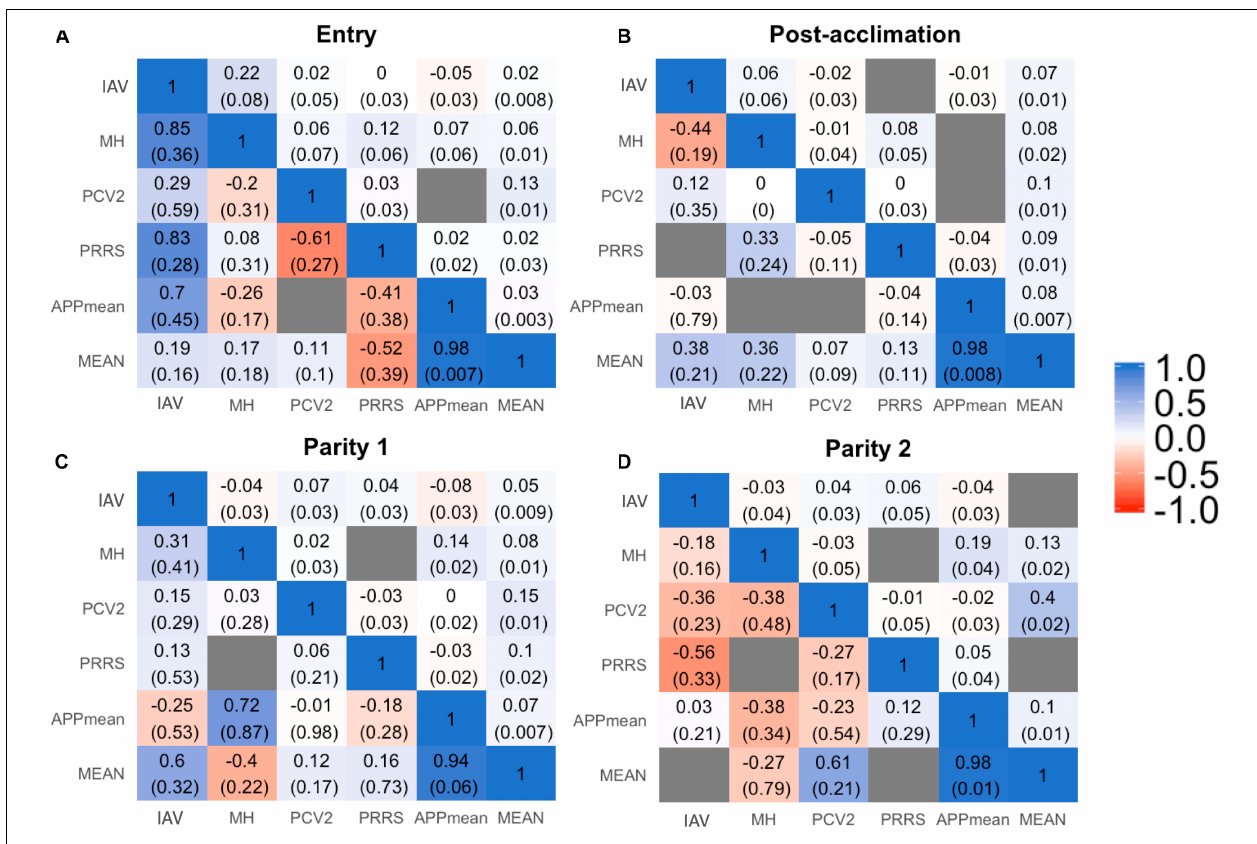
FIGURE 3 | Genetic (lower triangular) and phenotypic (upper triangular) correlation between all the traits influenza A virus (IAV), porcine circovirus type 2 (PCV2), Mycoplasma hyopneumoniae (MH), porcine respiratory and reproductive syndrome (PRRS), average of all Actinobacillus pleuropneumoniae (APP mean ), and overall mean of antibody response for all diseases (MEAN) at entry (A) , post-acclimation (B), Parity 1 (C) , and Parity 2 (D) . The seroconverted dataset with higher heritability within each time-point was used for these analyses. The blue color corresponds to positive correlation, the red color to negative correlation, and the gray color when the model did not converge.